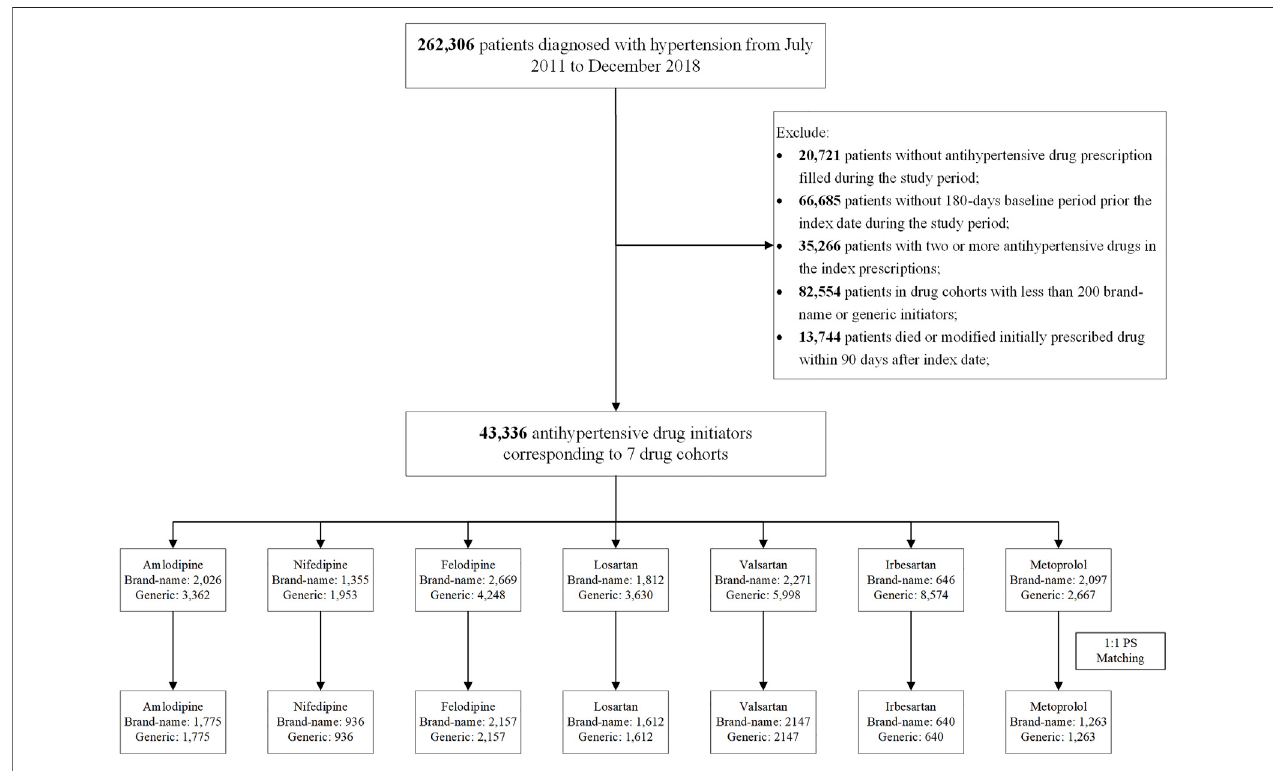
FIGURE 1 | Flow of sample